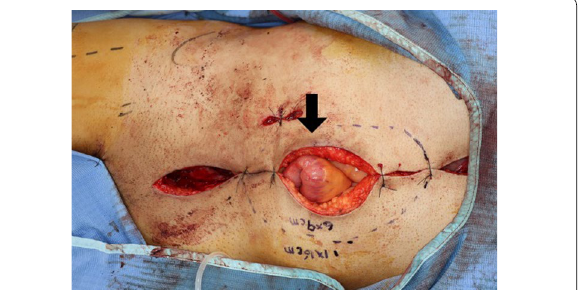
Fig. 5 Intraoperative photograph. The post-excision defect at the anterior abdominal wall involved 11 skin (black arrow)